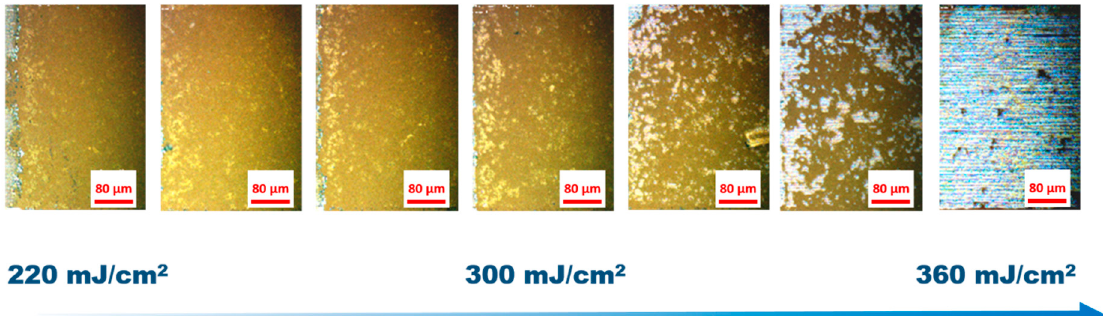
Figure 3. Effects induced by laser radiation on FTO layer, after a P2 process repeated 2 times (raster scanning distance (RSD) = 2 μ m) and by employing a laser fluence ranging from 220 mJ·cm − 2 to 360 mJ·cm − 2 . A clear FTO damage is induced by a laser fluence value starting from 300 mJ·cm − 2 , till to the complete FTO removal at 360 mJ·cm − 2 .